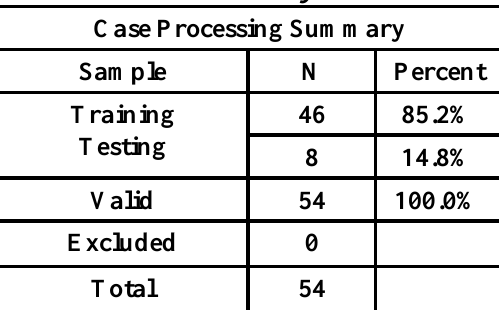
Table 3: Summary